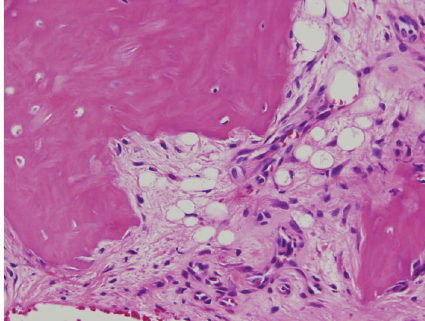
Figure 4: Histopathological findings, HE staining ( × 40).